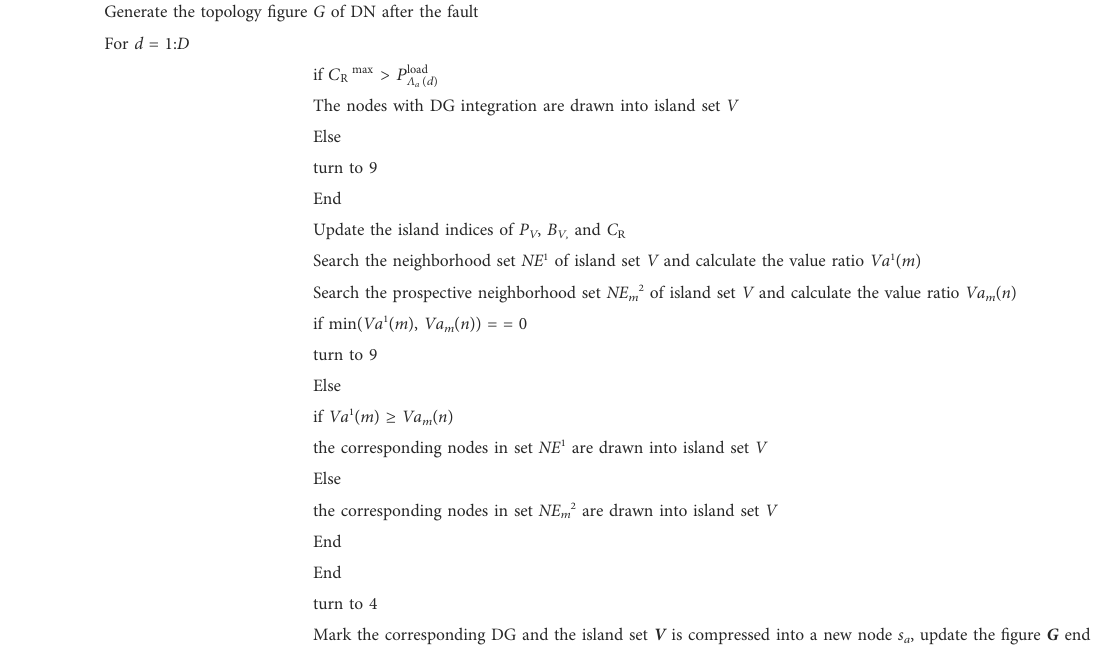
Generate the topology fi gure G of DN after the